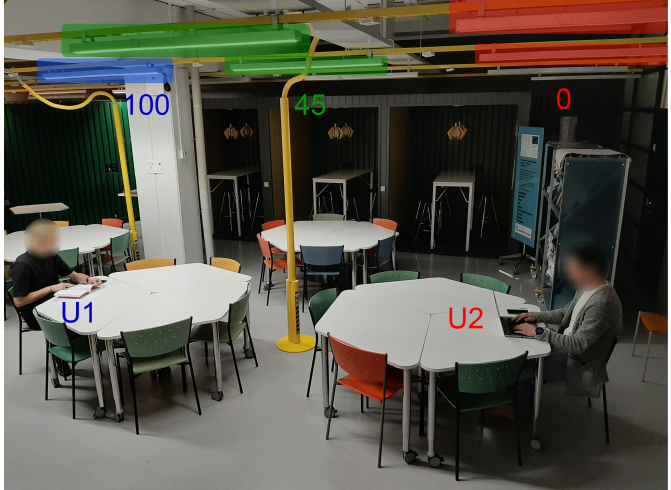
Figure 13. Two users, U1 and U2, use the system. Here, U1 wants to maximize lighting with preference level 100 (maximum light), whereas U2 wants to minimize lighting and has a preference level of 0 (no light). The shared luminaires in between (green) output level 45, since they are a bit closer to U2. The other luminaires in the picture are not in range for these users and since there is no one else in the space, they are turned off.